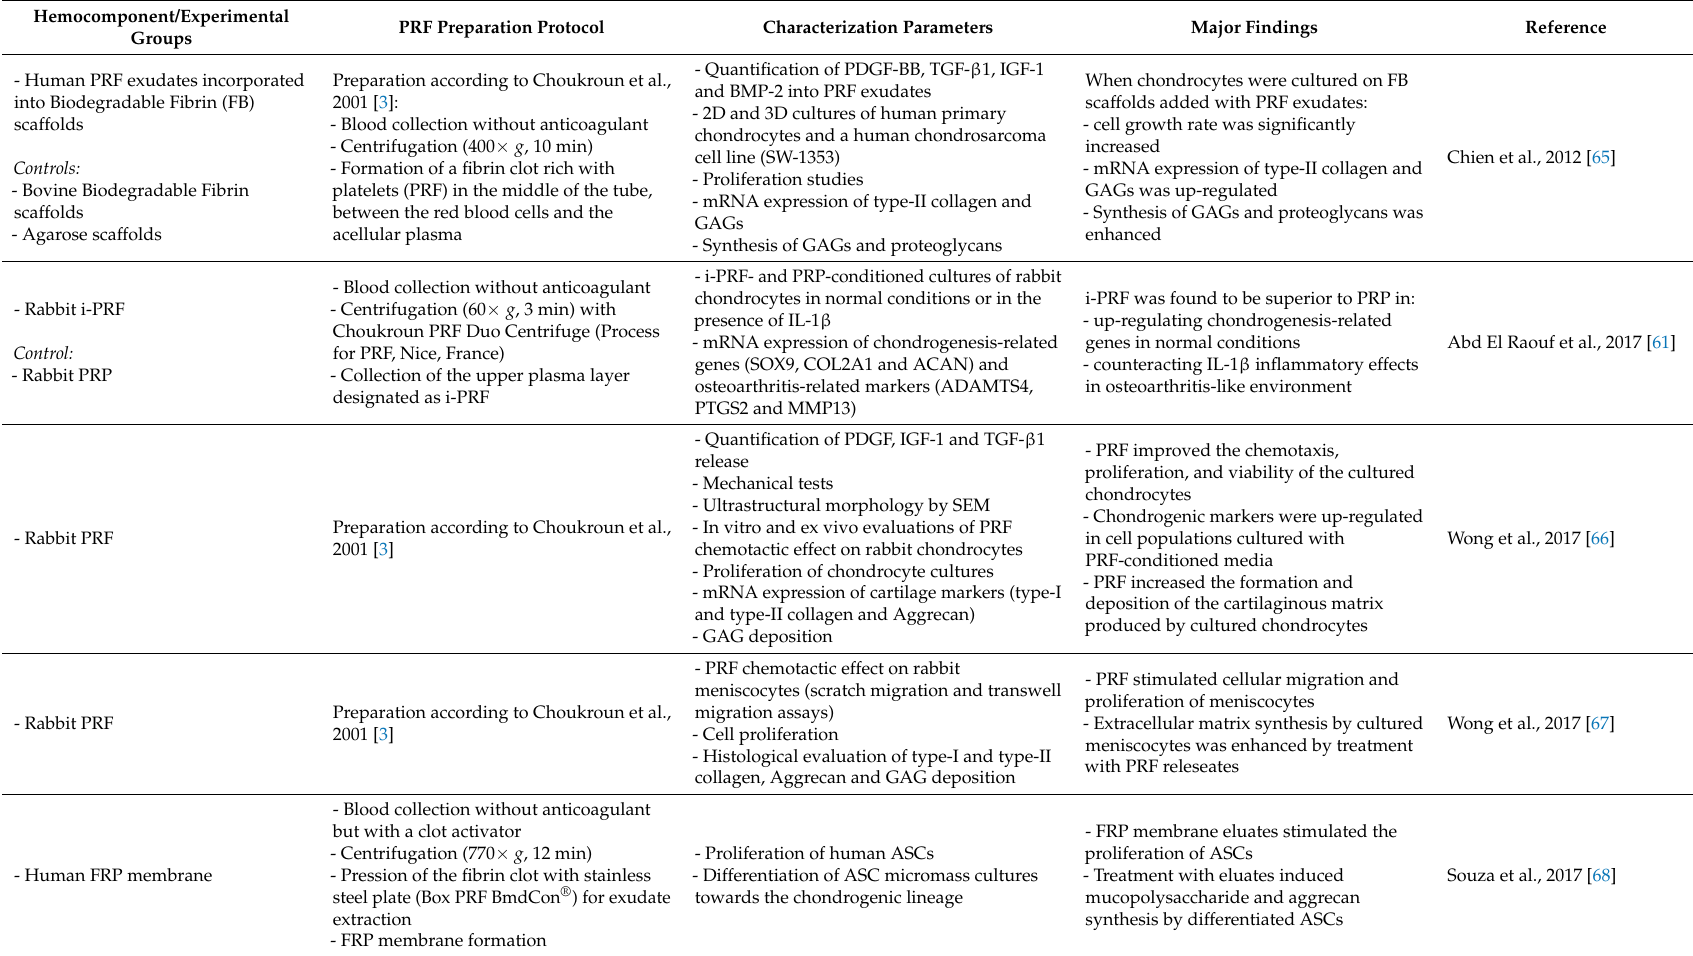
Table 1. In vitro studies of PRF chondrogenic